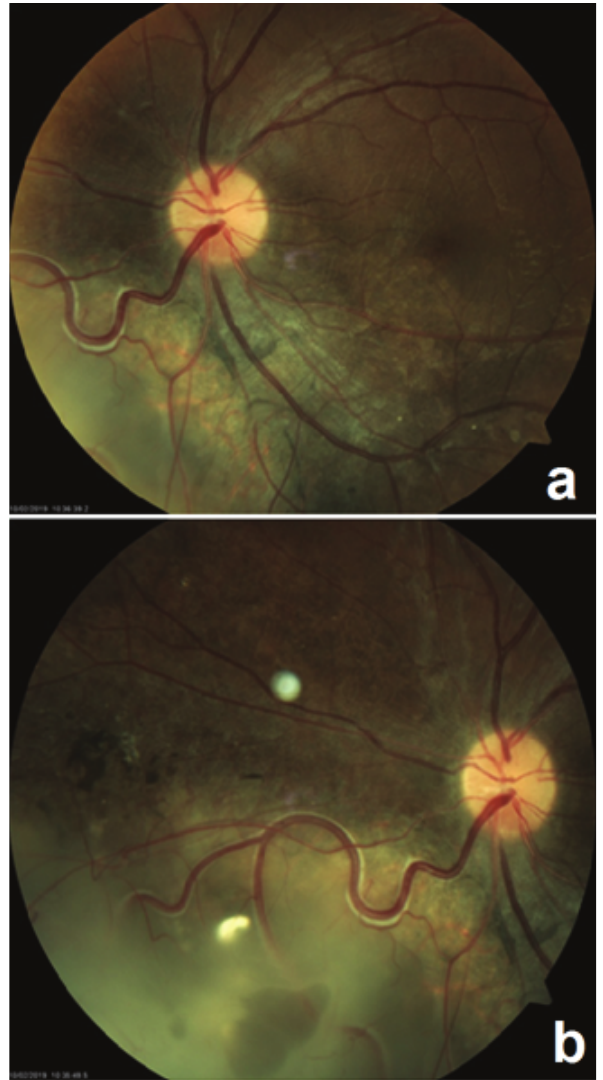
Figure 1. (a) Posterior fundus view of the left eye demonstrating the distance between the mass and fovea. (b) Regressed retinoblastoma with intralesional cavitation, inferonasal to the optic